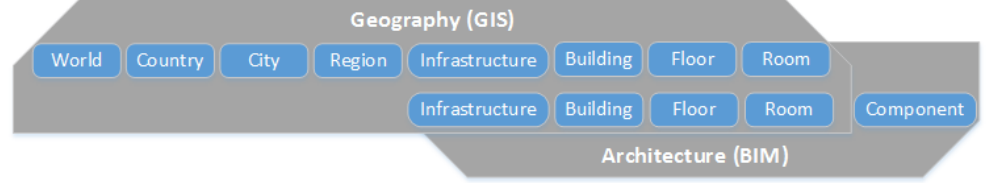
Figure 2. Overlap between the fields of GIS and BIM.